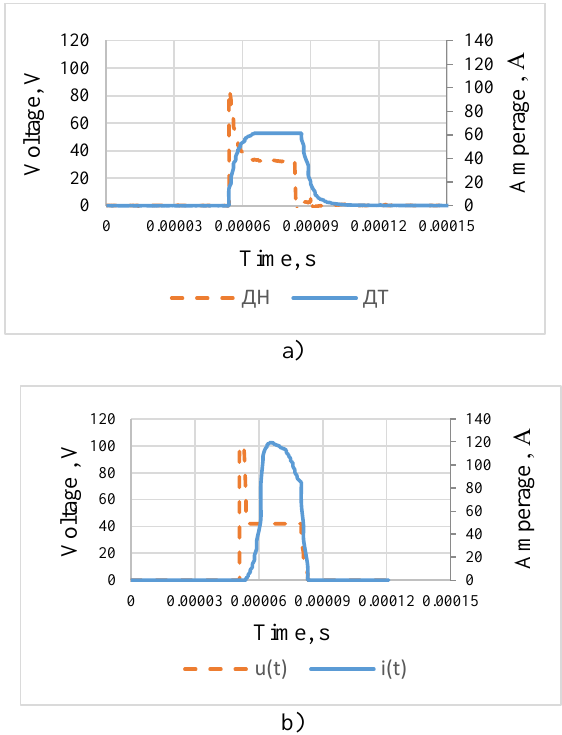
Fig. 5. Comparison of the results of the experiment (a) and simulation (b) on the example of a single pulse at a working